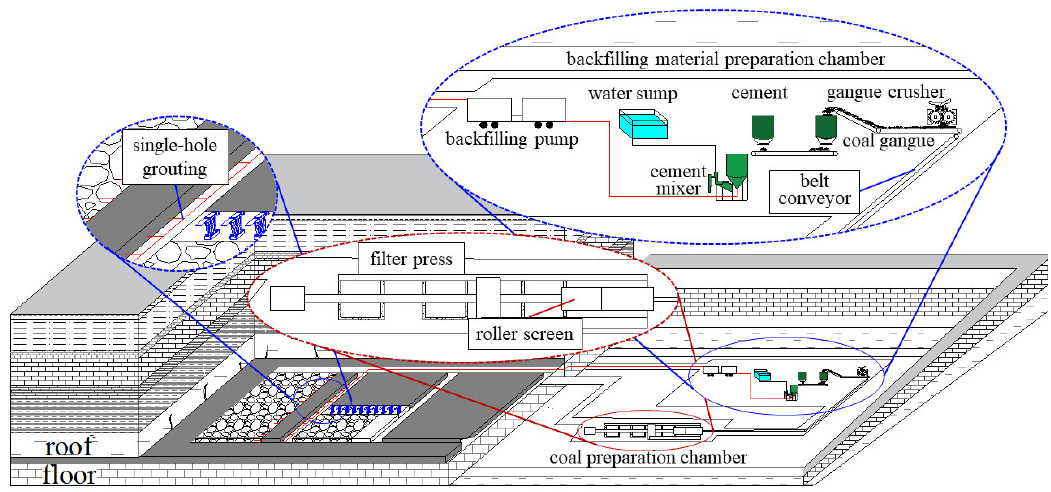
Figure 5. Schematic diagram of slurry backfilling in the